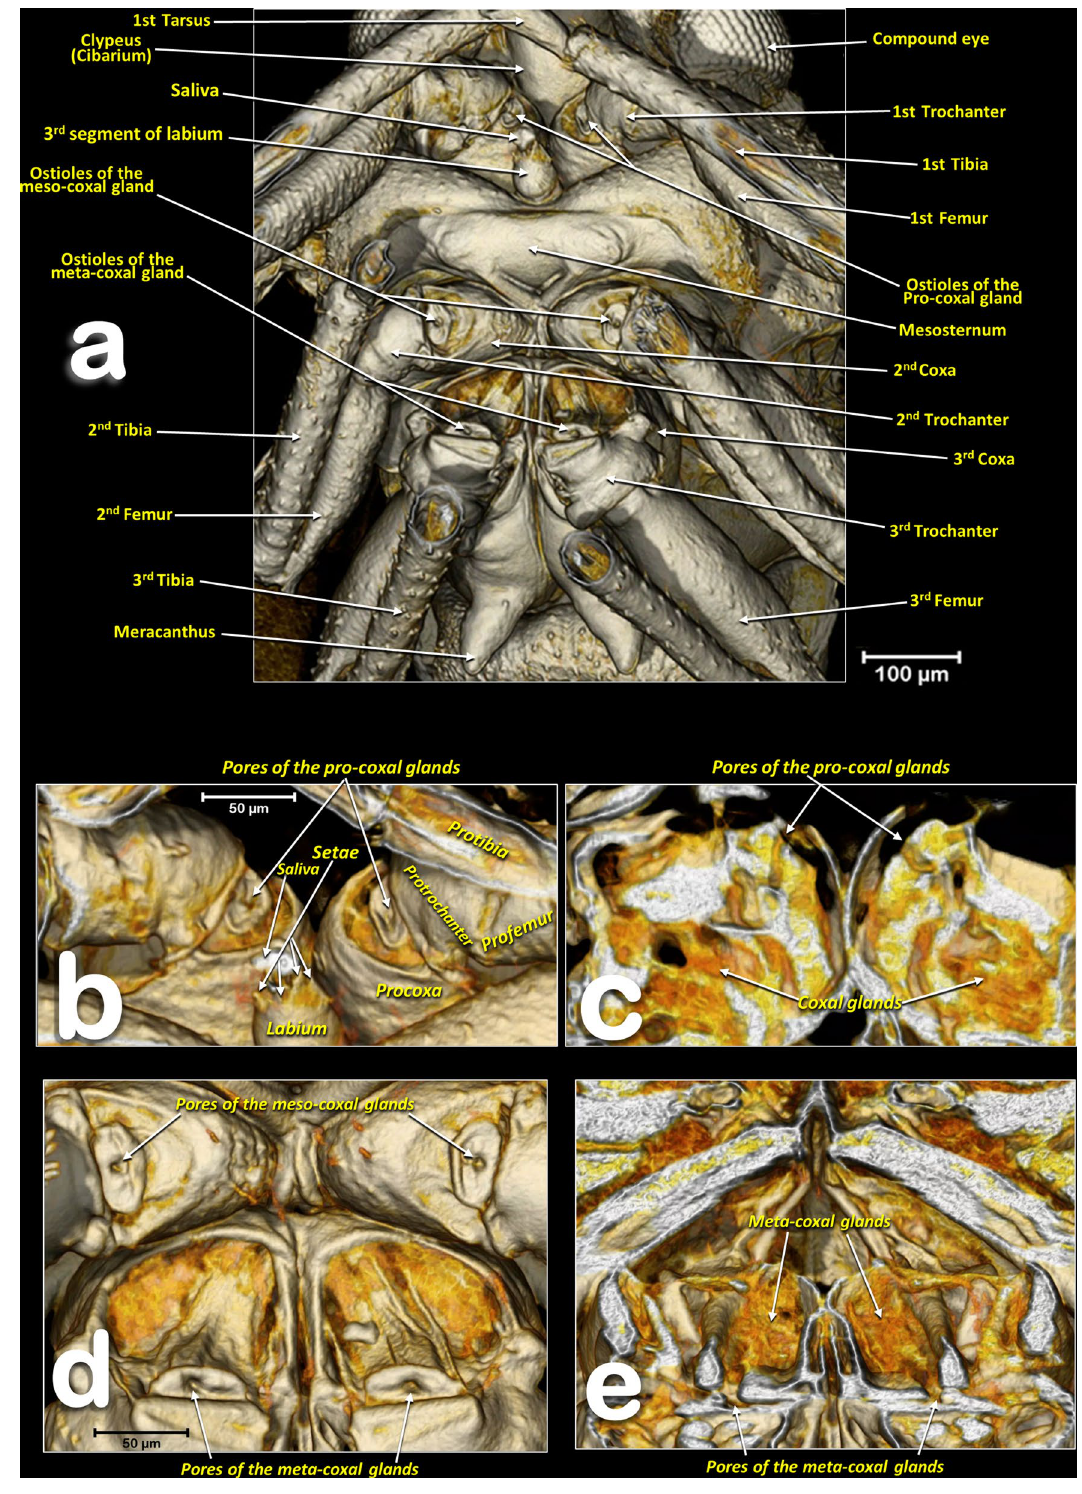
Figure 5. Volume-rendered images of the anterior half of a female Diaphorina citri , in a ventral view, showing the main anatomical structures and the ostioles of the coxal glands ( a ). Close-up the ostioles of the coxal glands ( b – d ), and antero-posterior oblique virtual cuts showing the coxal gland tissue inside the coxae ( c – e